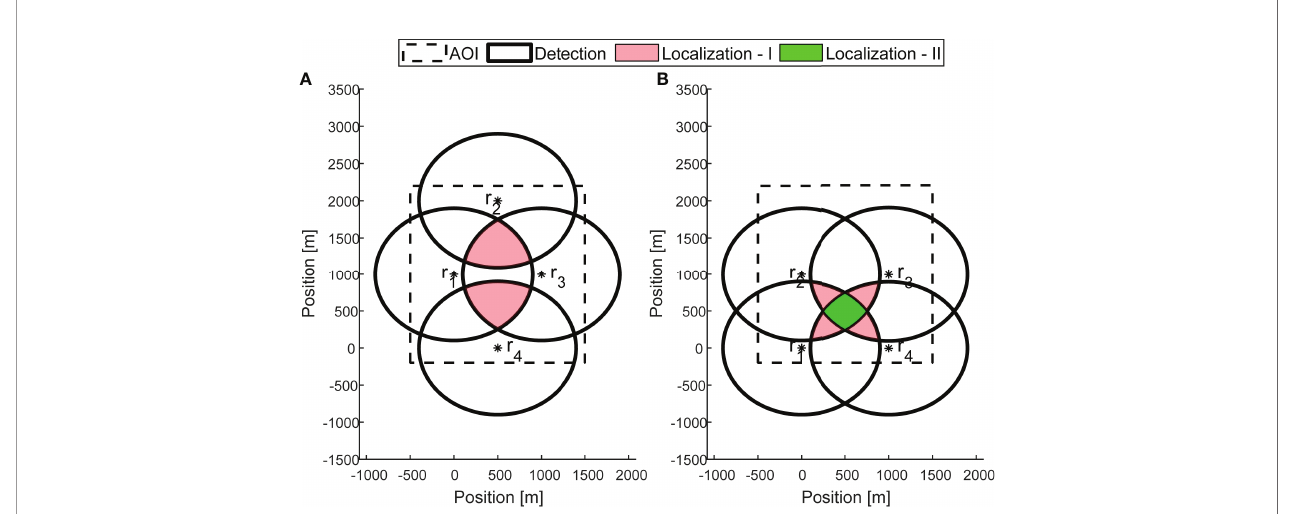
FIGURE 1 | An example showing the deployment of N = 4 receivers (cid:1) r 1 , (cid:1) r 2 , (cid:1) r 3 , (cid:1) r 4 , with corresponding detection areas marked by black contour lines. For the case of b = 3, in deployment setup (A) , although J = 5, there are two localization areas, L ( l 1 ), L ( l 2 ) , marked by the light red shading. The two sets of at least 3 receivers are l 1 = f (cid:1) r 1 , (cid:1) r 2 , (cid:1) r 3 g and l 2 = f (cid:1) r 1 , (cid:1) r 3 , (cid:1) r 4 g . The coverage area, C , is the union of L ( l 1 ), L ( l 2 ) . In the deployment setup (B) , the light red areas form “ Localization area - I ” , which merges localization areas L ( l